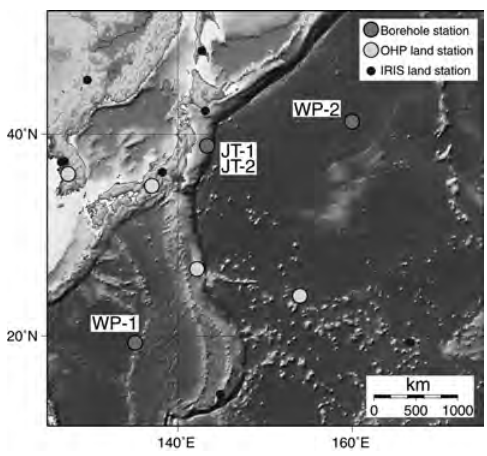
Fig. 1. Location map of seismic station coverage in the northwest Pacific. Small black and light gray cir- cles indicate land seismic stations, dark gray circles are seafloor borehole observatories. The WP-1 and WP-2 observatories were installed in August 2000 and April 2001, respectively. Note that a few bore- hole stations can effectively complement and expand the existing